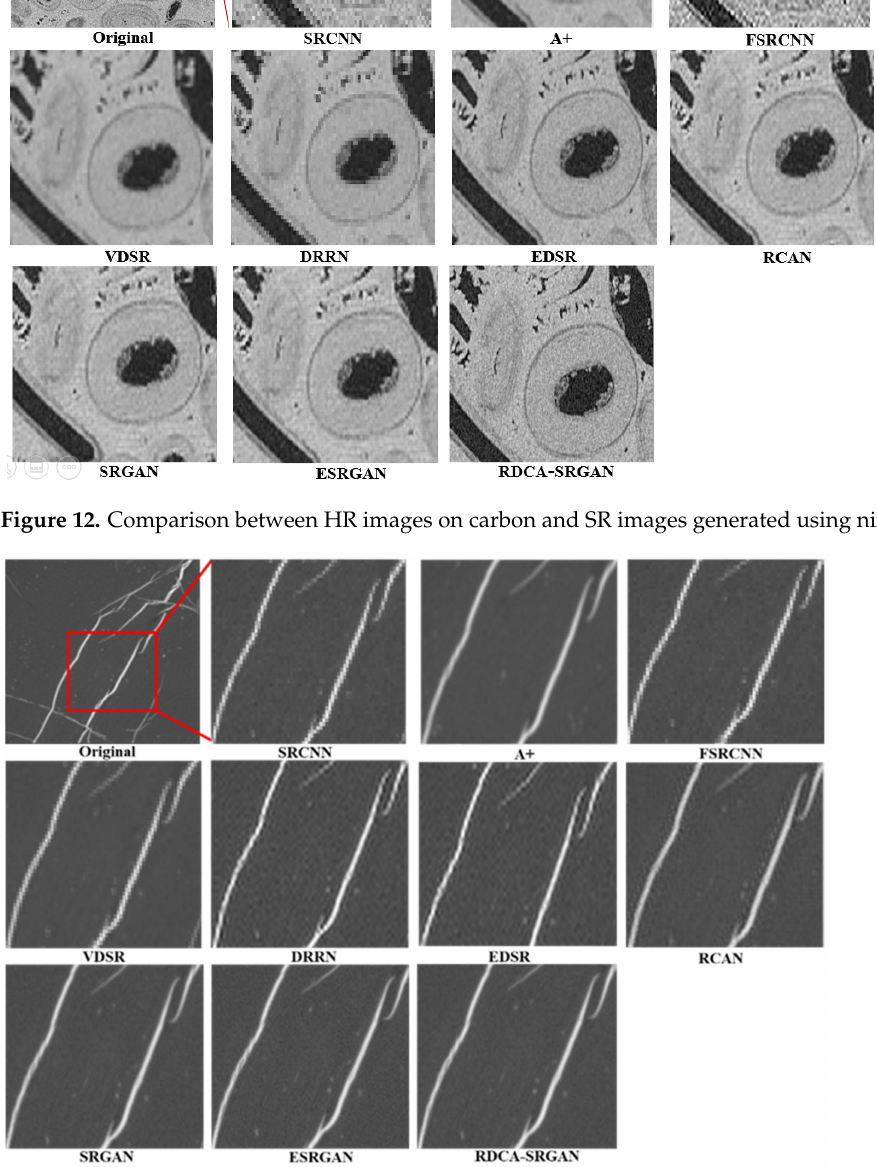
Figure 13. Comparison between HR images on coal and SR images generated using nine